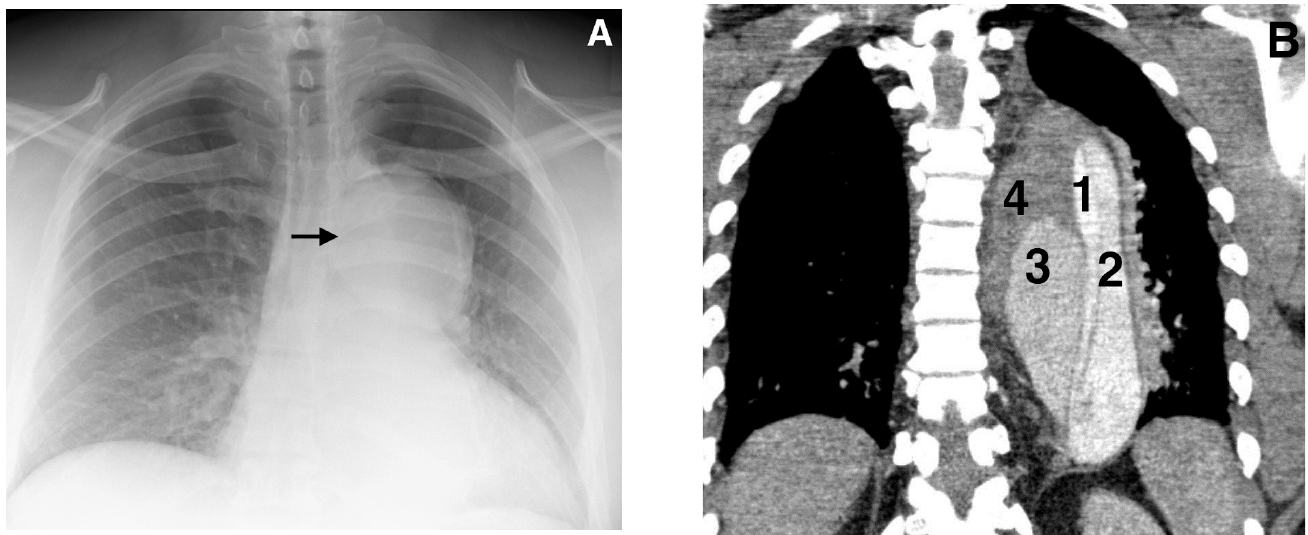
Figure. A, Chest radiograph revealing a left mediastinal mass. B, Complex thoracic aortic dissection originating at aortic root. 1) true lumen 2) acute dissection 3) acute dissection 4) chronic